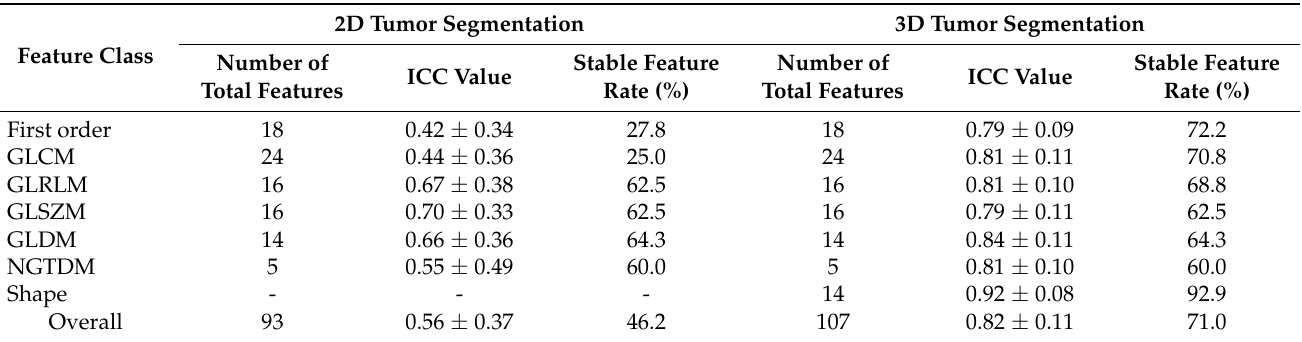
Table 3. Inter-observer variability of the radiomic-features family and stable feature rate for 2D and 3D tumor segmentations.